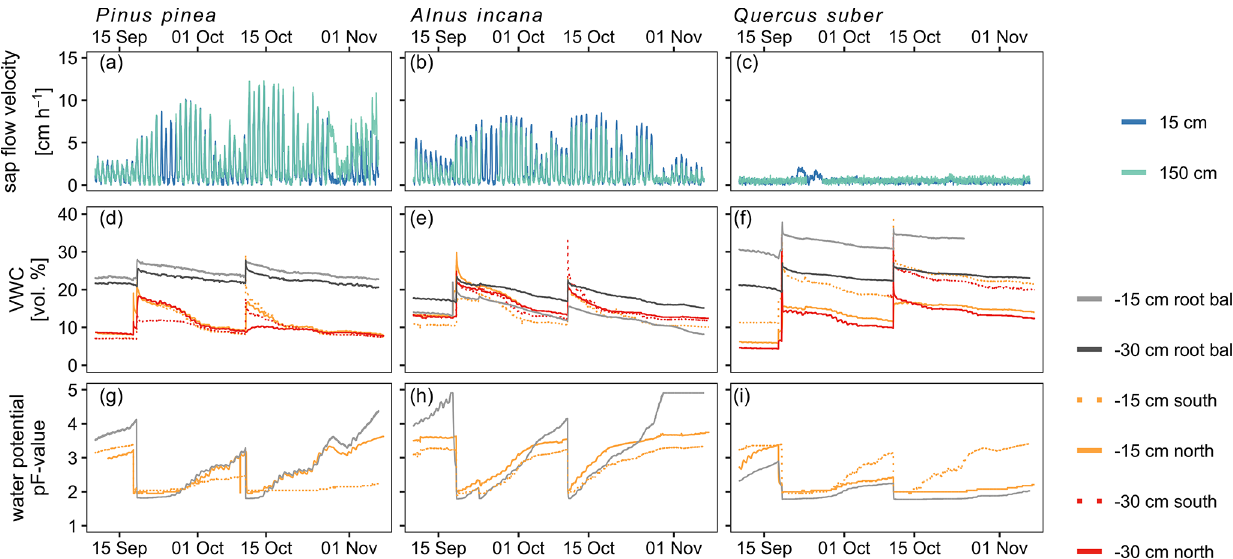
Figure 3. Daily median stable water isotope measurements with in situ probes in xylem and soils. 2 H and 18 O are shown in δ notation, while deuterium excess is calculated as follows: d = δ 2 H − 8 × δ 18 O (Dansgaard, 1964). For reference, plots include destructive measurement campaigns (light grey) and labeling dates (dark grey) as well as summer precipitation (cross) and pre-event irrigation isotope signal (triangle). δ 2 H for label 1 was + 41 . 2‰ and + 95 . 1‰ for label 2, while δ 18 O was equal to pre-experiment irrigation ( − 9 . 2‰).